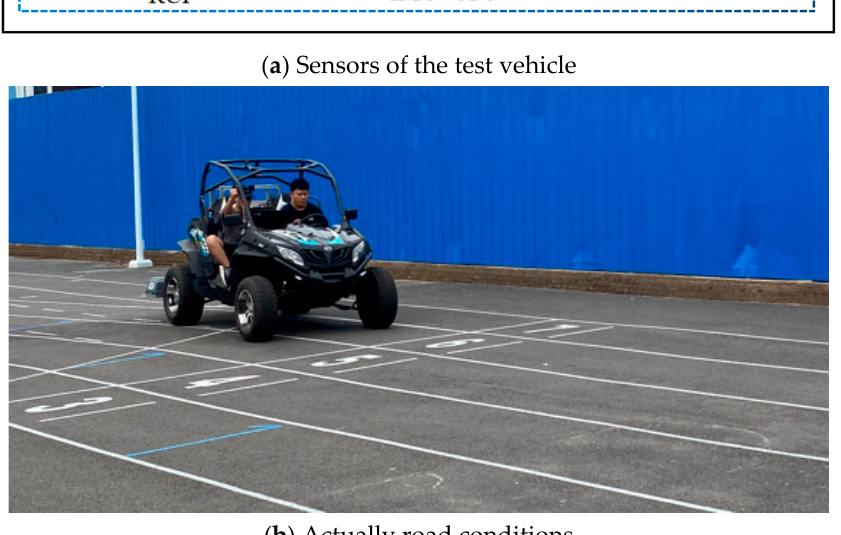
Figure 15. Experimental sensors of the test vehicle and actual road conditions.